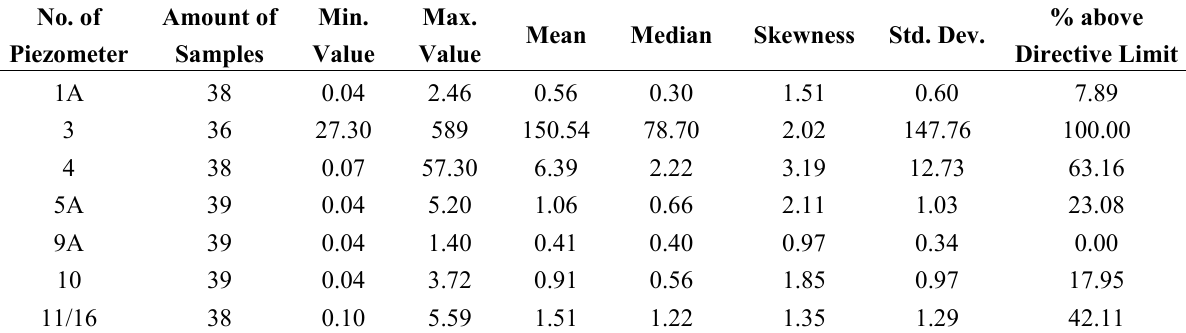
Table 2. Statistical evaluation and summary of ammonium concentrations [mgNH 4 -N/L] in the groundwater samples for selected piezometers (after vertical barrier